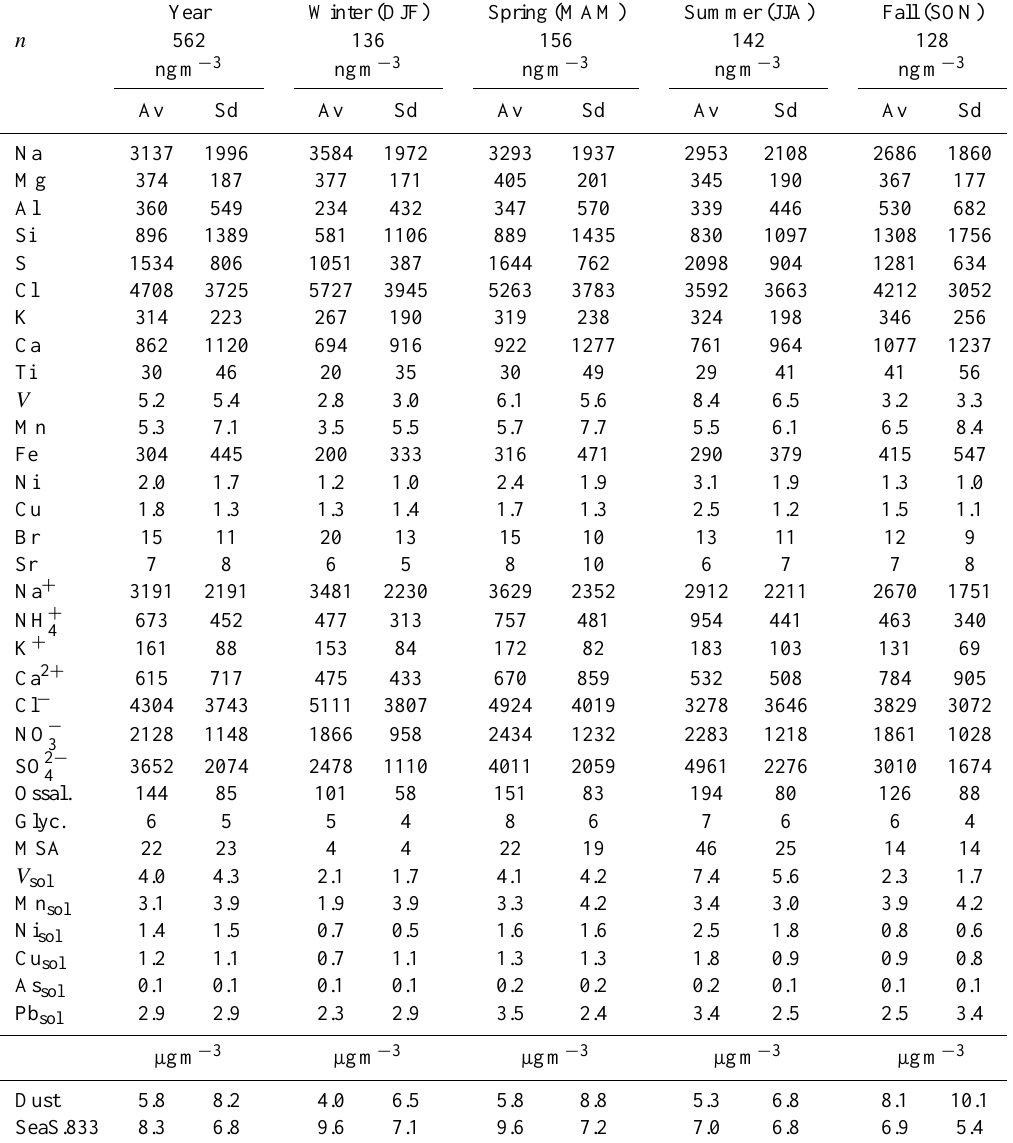
Table 1. Average concentrations (Av) and standard deviation (Sd) of the main measured elements/species for all the sampling period and in the different